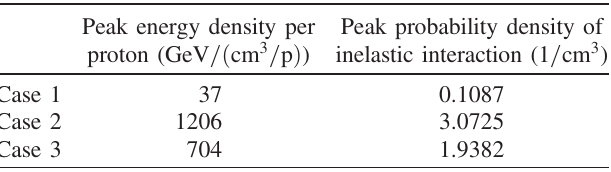
TABLE VI. Peak energy density deposited per lost proton, calculated by FLUKA , and peak density of inelastic interactions of SIXTRACK macroparticles for the cases discussed in the paper.